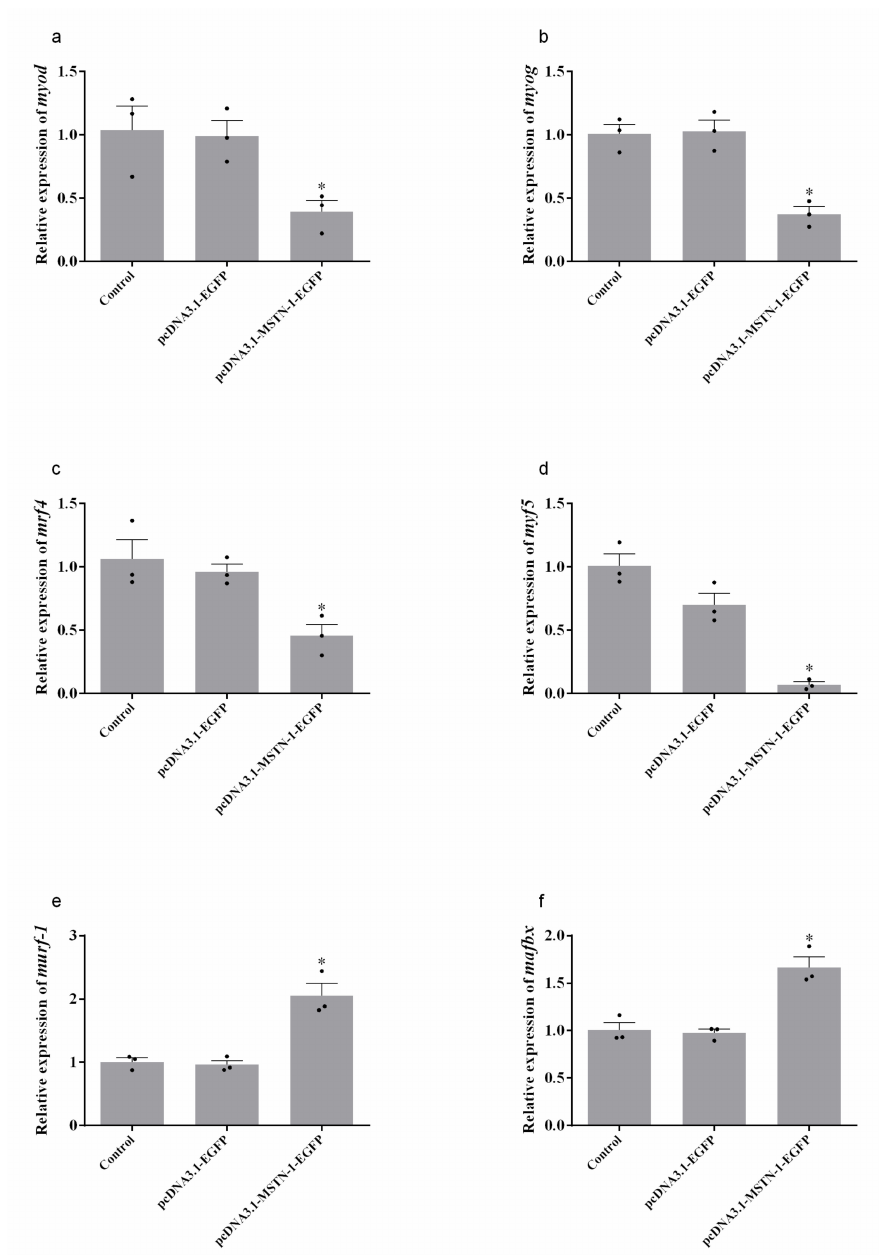
Figure 8. Relative expression of muscle growth-related genes and proteolysis-related genes after mstn-1 overexpression in Japanese flounder primary muscle cells. ( a ) Relative expression of myod . ( b ) Relative expression of myog . ( c ) Relative expression of mrf4 . ( d ) Relative expression of myf5 . ( e ) Relative expression of murf-1 . ( f ) Relative expression of mafbx . Results are represented as mean ± SE ( n = 3). * means significantly di ff erent compared with control ( p <